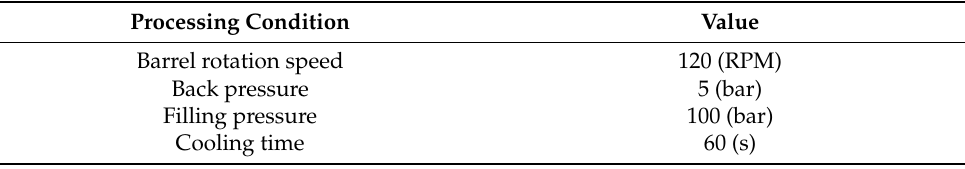
Table 1. Processing conditions for the injection molding of LDPE